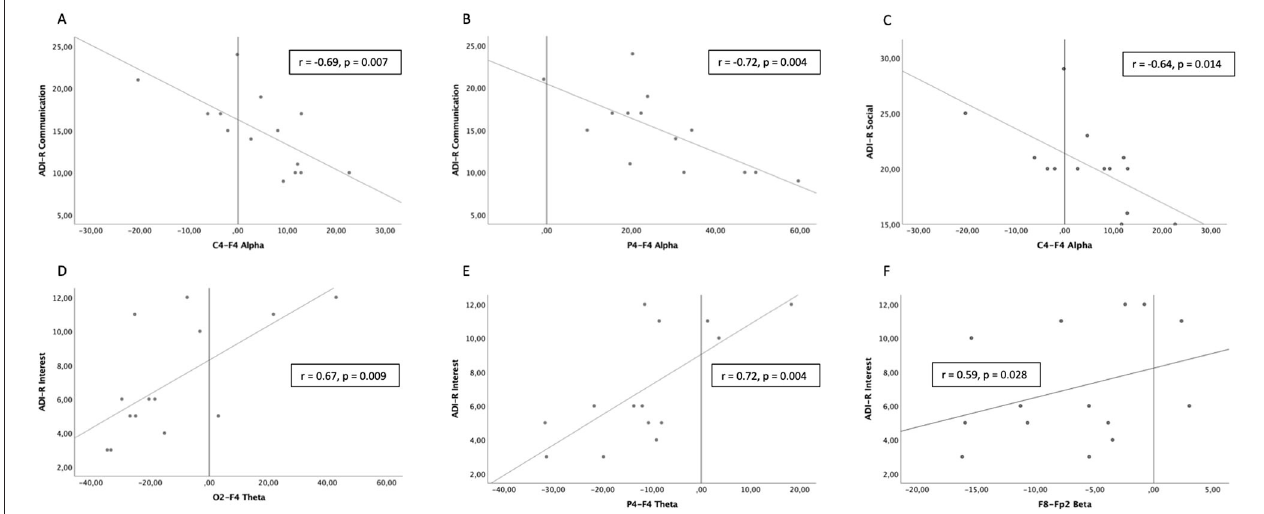
FIGURE 4 | Significant correlations between scores on the Autism Diagnostic Interview-Revised (ADI-R) and intrahemispheric ratios of EEG activity in Autism Spectrum Disorder (ASD) participants. (A,B) Communication scores with C4-F4 and P4-F4 activity ratios in the alpha frequency range. (C) Social interaction scores with C4-F4 activity ratios in the alpha frequency range. (D,E) Restricted interests and repetitive behaviors scores with O2-F4 and P4-F4 activity ratios in the theta frequency range. (F) Restricted interests and repetitive behaviors scores with P8-Fp2 activity ratios in the beta frequency